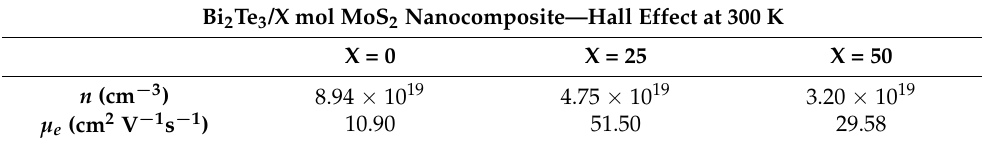
Table 1. Carrier concentrations and mobility of the Bi 2 Te 3 /X mol MoS 2